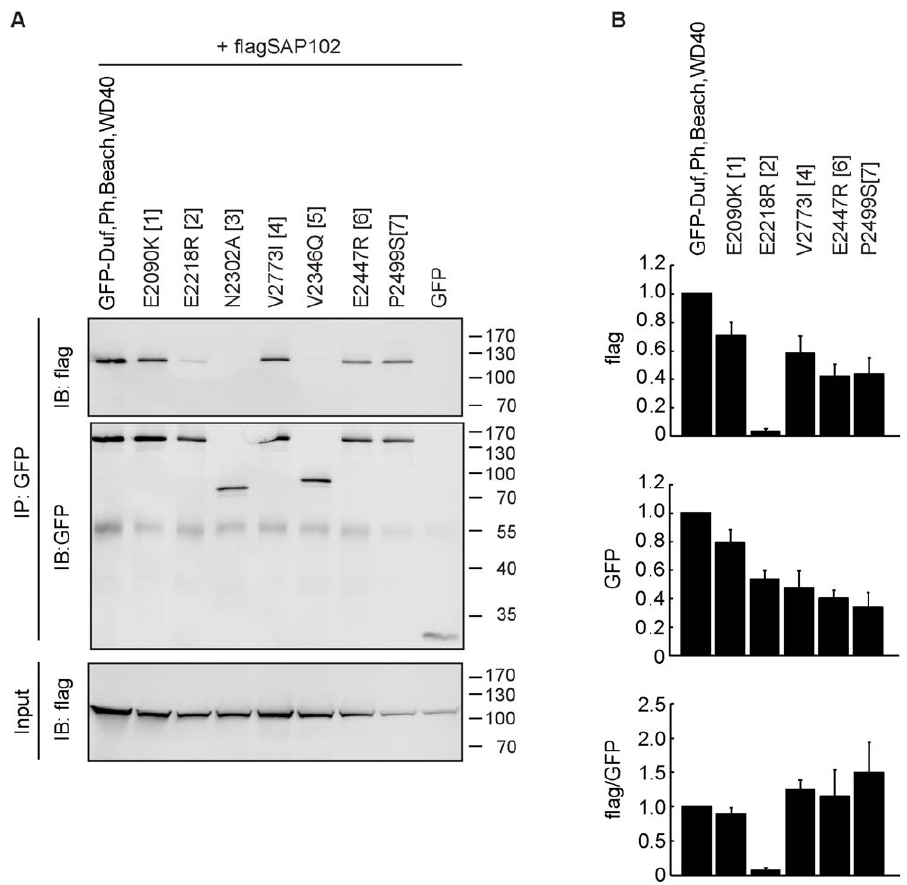
Figure 4. The E2218R mutation within the PH domain abolishes Nbea’s binding to SAP102. (A) HEK293 cells were co-transfected with flag-tagged SAP102 and either the non-mutated C-terminal part of Nbea (encompassing the Duf, PH, BEACH and WD40 domains) fused to GFP or the mutated versions of this protein. The following mutations were used: E2090K in the DUF domain (1), E2218R in the PH domain (2), N2302A in the BEACH domain (3), V2773I in the WD40 domain (4), and an additional three mutations within the BEACH domain, V2346Q (5), E2447R (6) and P2499S (7) (B) Quantification of FLAG-tagged and GFP-tagged protein levels of the immuno-blot. Error bars indicate the standard error of the mean (SEM).